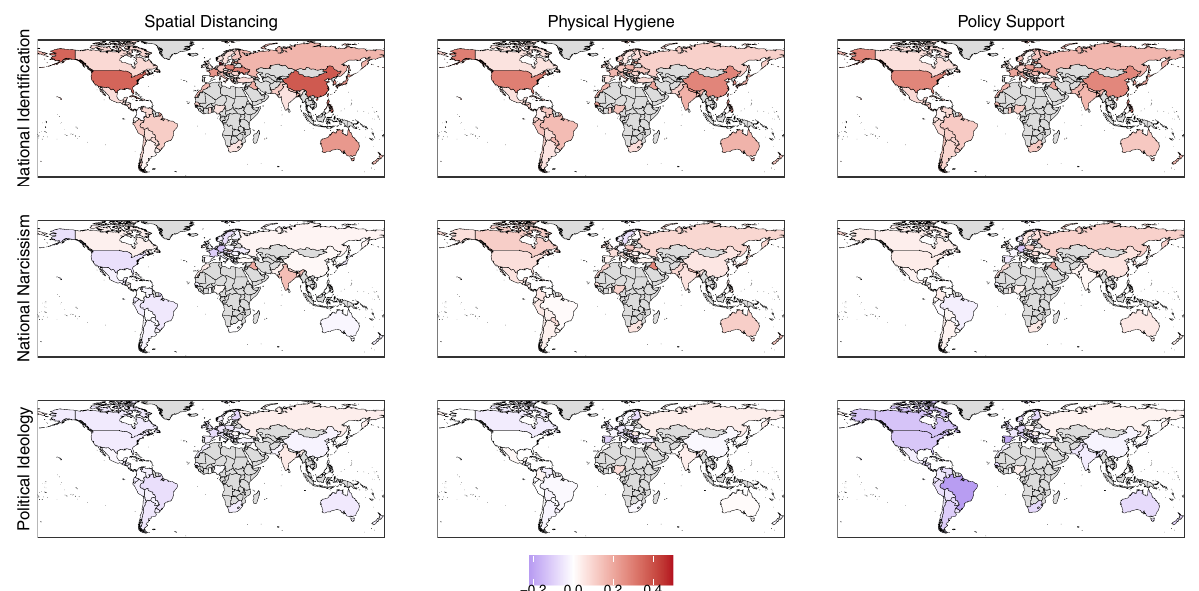
Fig. 2 Relationships between collective concerns and public health measures in 67 countries and territories. Heat index depicts the slope coef fi cients in each country. Blueish colours indicate negative associations between our predictors and our outcomes while reddish colours indicate positive associations (higher scores re fl ect stronger relationships between national identi fi cation, greater national narcissism and greater conservatism, and limiting physical contact, improving hygiene, and supporting public health policies). All the worldmaps were produced using R packages. The map is from the package ‘ rworldmap ’ and is licensed-free from South, A. (2011). rworldmap: A New R package for Mapping Global Data. The R Journal, 3,